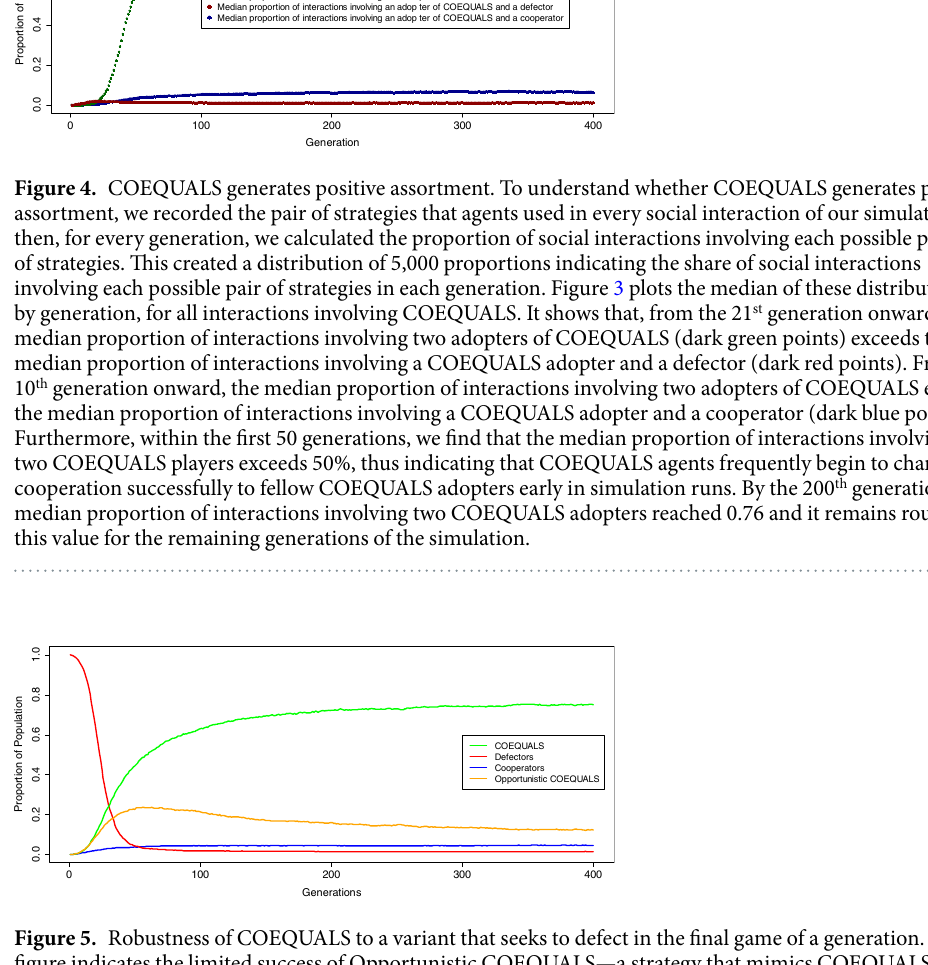
A pattern does appear in Panel (G) of Fig. 3, which displays the relationship between COEQUALS’ popu- lation shares at g = 400 and the proportion of the population’s wealth holdings that an adopter of COEQUALS can view. Panel (G) of Fig. 3 shows that when an adopter of COEQUALS can view the wealth of less than 10% of the population, COEQUALS rarely spreads to a majority of the population’s agents. However, when an